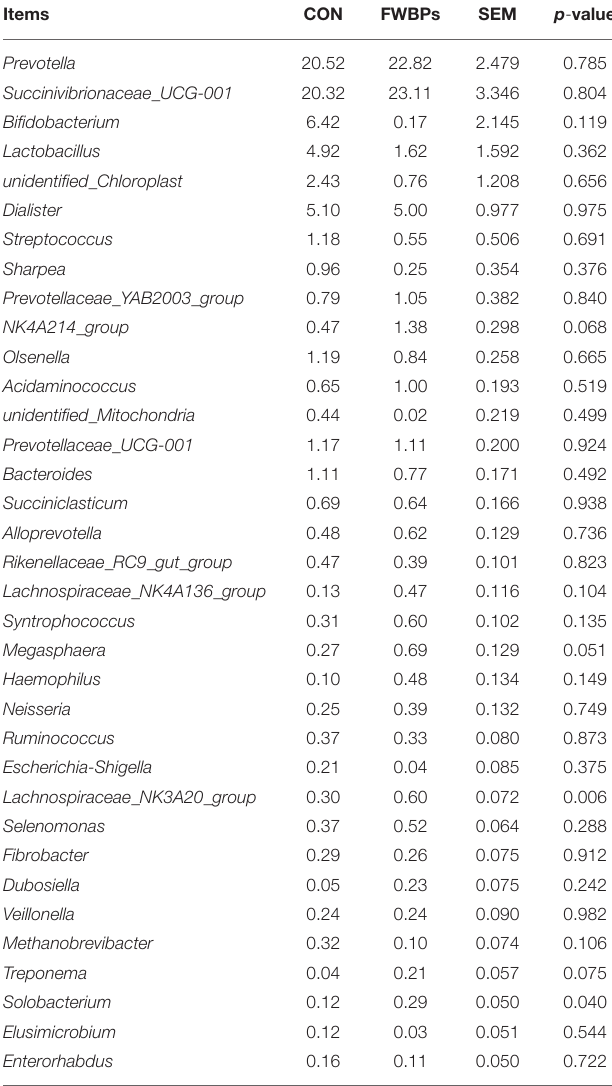
TABLE 8 | Effects of FWBPs on the ruminal microbiota of early-weaned lambs (genus level) %.